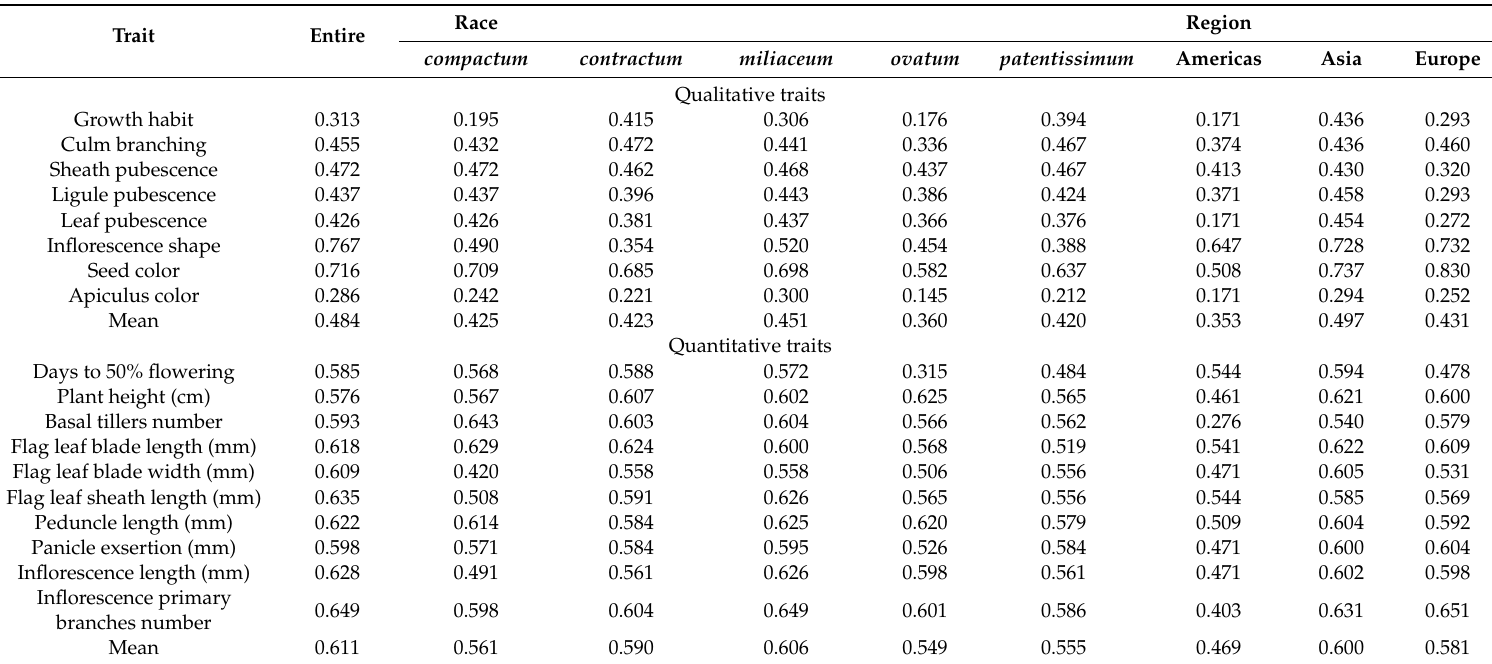
Table 3. Shannon–Weaver diversity indices (H (cid:48) ) of eight qualitative and ten quantitative traits in the entire set, five races and regions of proso millet germplasm conserved at the ICRISAT genebank, Patancheru,